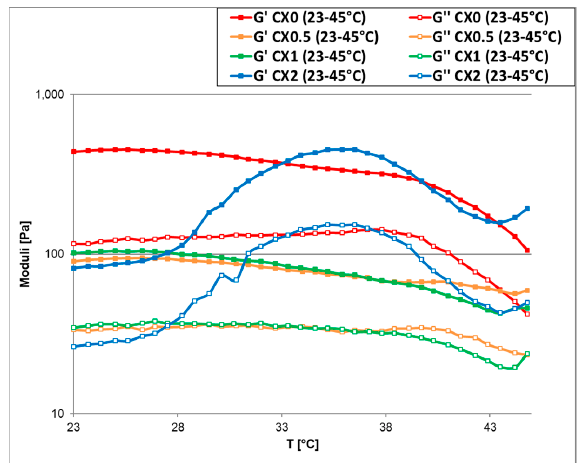
Figure 3. Trends of G (cid:48) and G” as a function of temperature of samples prepared with the different concentrations of Bosexil ® (0%, 0.5%, 1%,